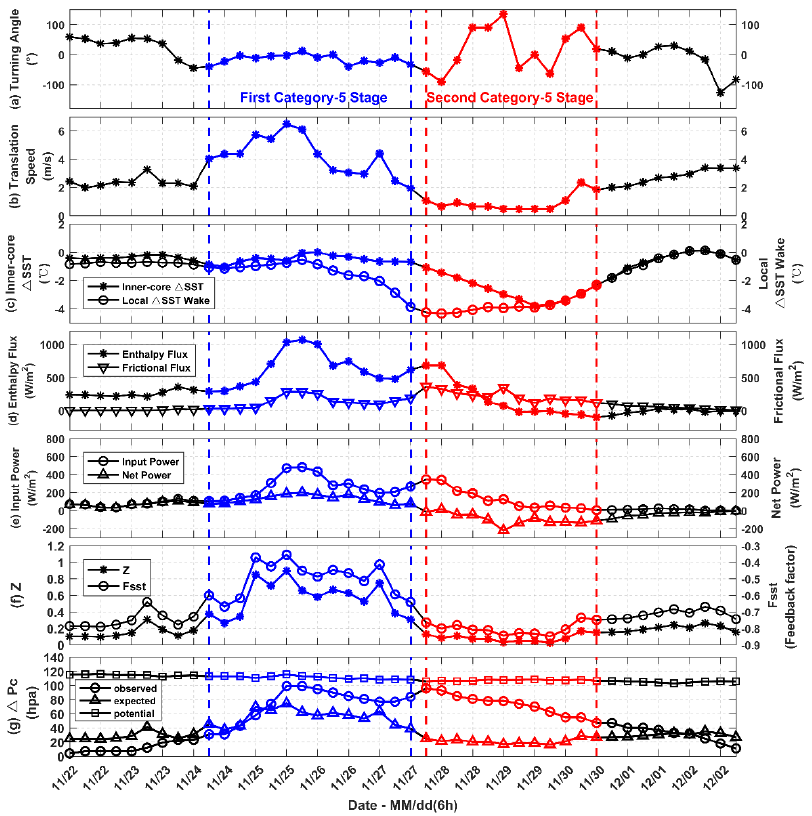
Figure 9. The ( a ) turning angle ( ◦ ), ( b ) translation speed (m s − 1 ), ( c ) inner-core SST cooling and local ∆ SST wake ( ◦ C), ( d ) enthalpy flux and frictional flux (W m − 2 ), ( e ) input power and net power (W m − 2 ), ( f ) feedback factor Fsst and reference value Z in Schade and Emanuel (1999), and ( g ) observed, expected and potential pressure depression in the eye of typhoon Nida during its passage. The blue and red segments indicate the straight-line stage and the sudden-turning stage of typhoon Nida, respectively.